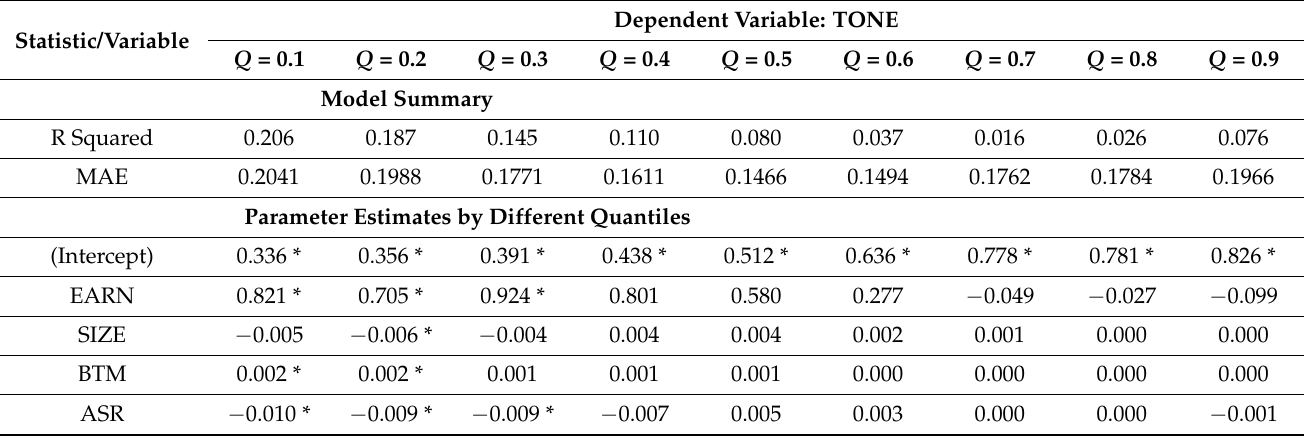
Table 5. Multivariate statistics and parameter estimates for EARN on